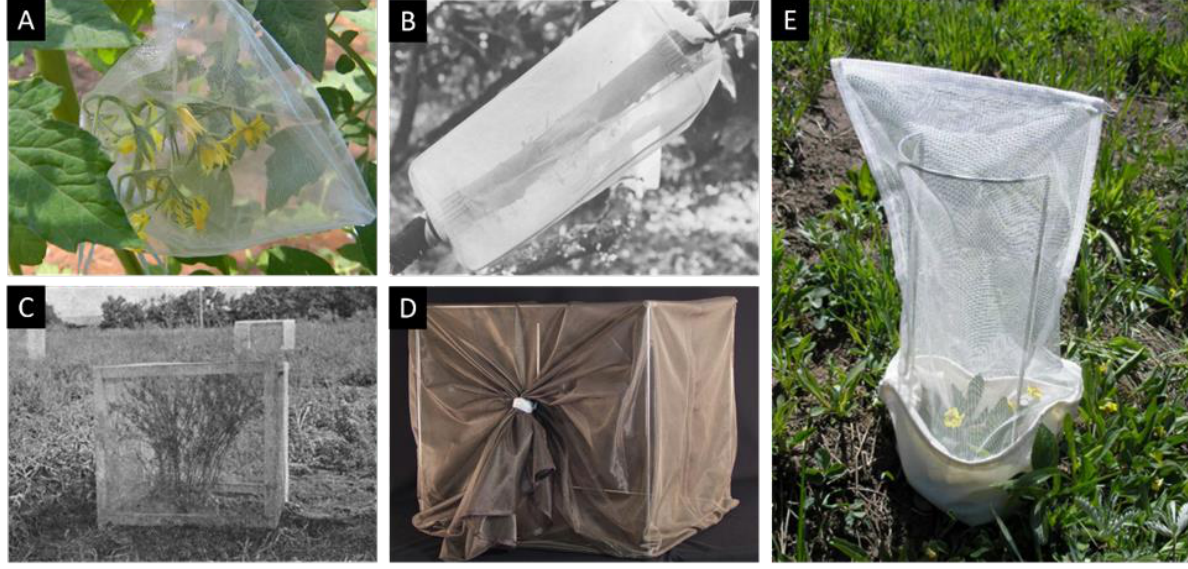
Figure 1. (A) Mesh exclosure around a plant without structural support (Dixon 2017) (B) Bag exclosure supported by wire (Young 1983) (C) Wooden-frame exclosures surrounding whole plant (Roberts & Freeman 1908) (D) Metal-frame exclosure with